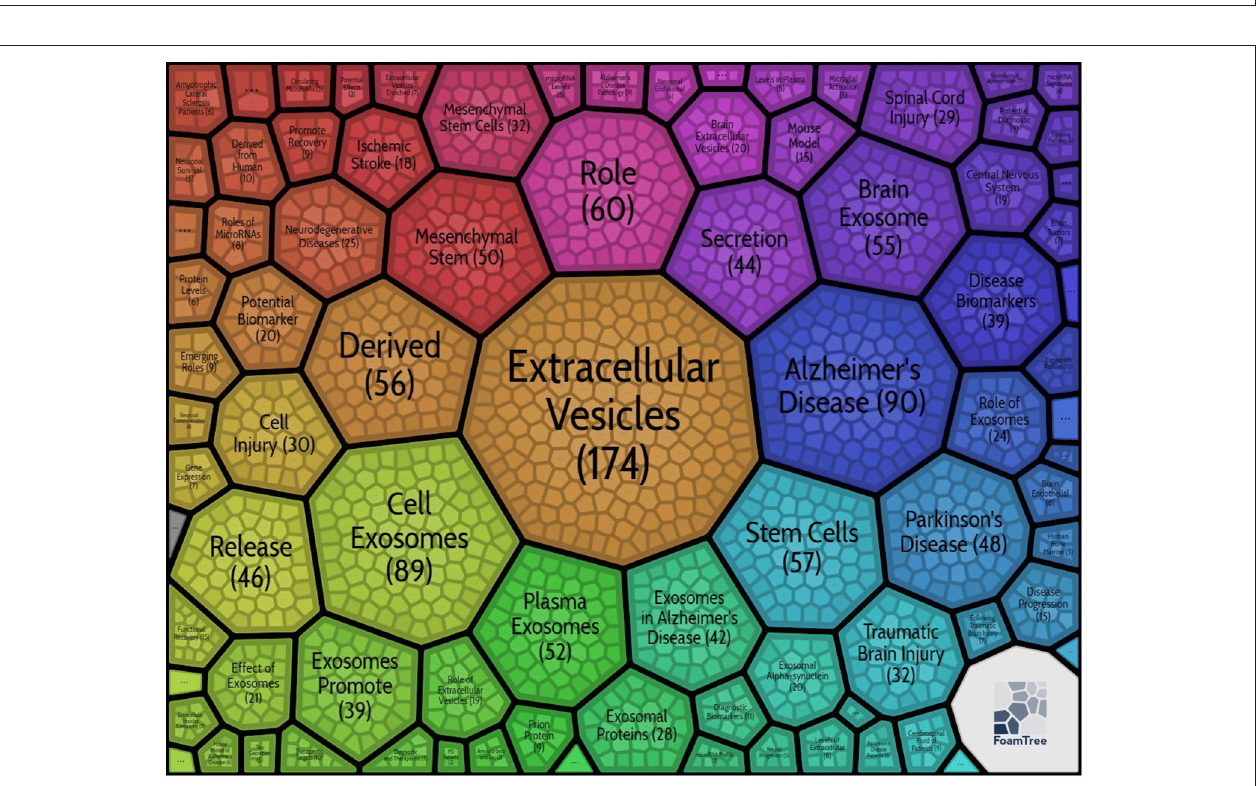
FIGURE 3 | Eight-six key words about exosomes in the field of neuroscience-based on titles clustering results.